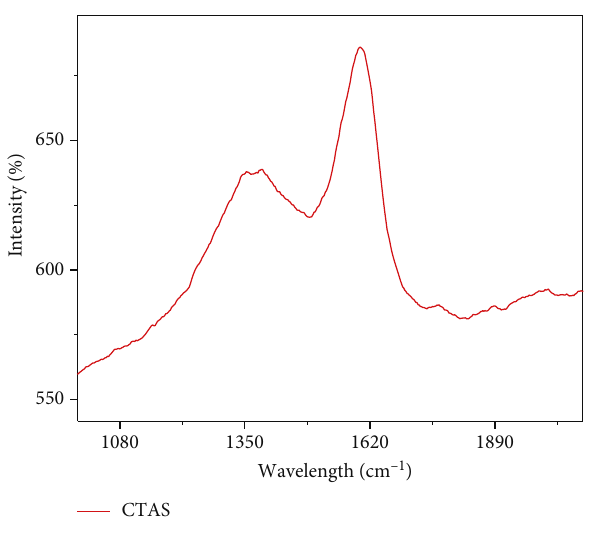
Figure 6: Raman Spectroscopy of CTASP.